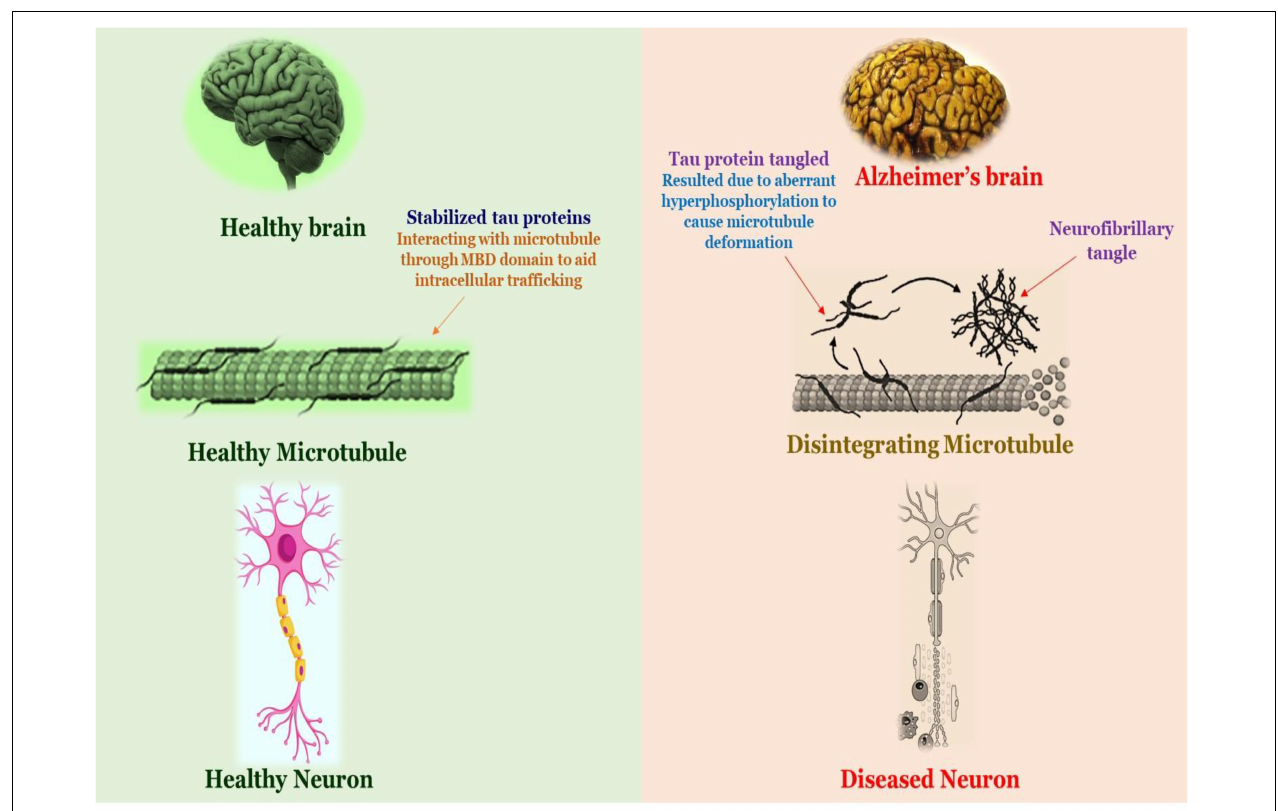
FIGURE 3 | Schematic diagram of the pathology of Alzheimer’s